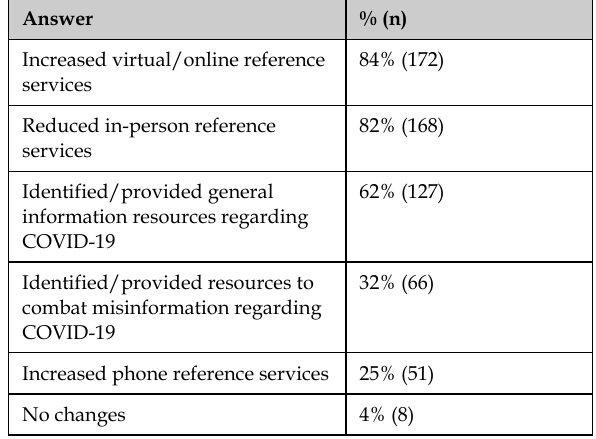
Figure 1 Volume of reference